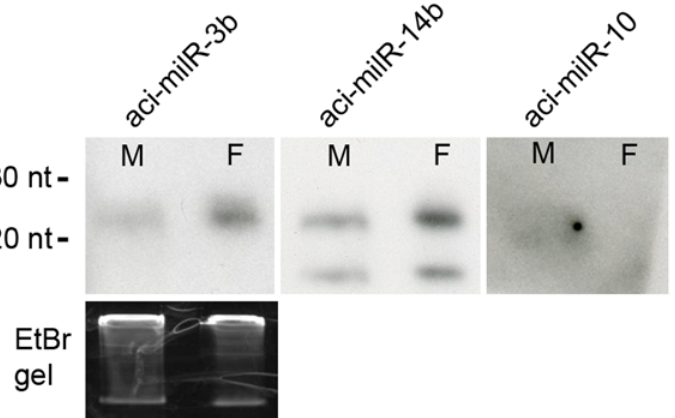
Fig 5. milRNAs identified in this study with Northern